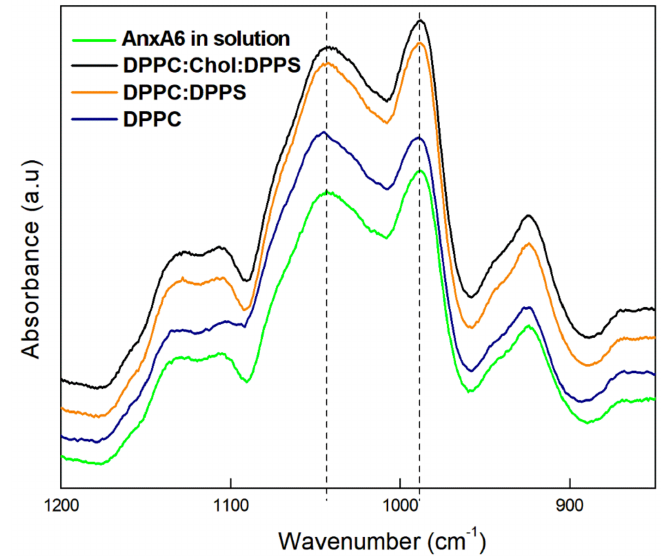
Figure 3. ATR—FTIR spectra of the minerals produced by proteoliposomes harboring AnxA6 after 30 h of incubation in SCL in absence of type-I collagen. Blue—DPPC; Orange—9:1 DPPC:DPPS; Black—5:4:1 DPPC:Chol:DPPS; and Green—Control: AnxA6 in solution.